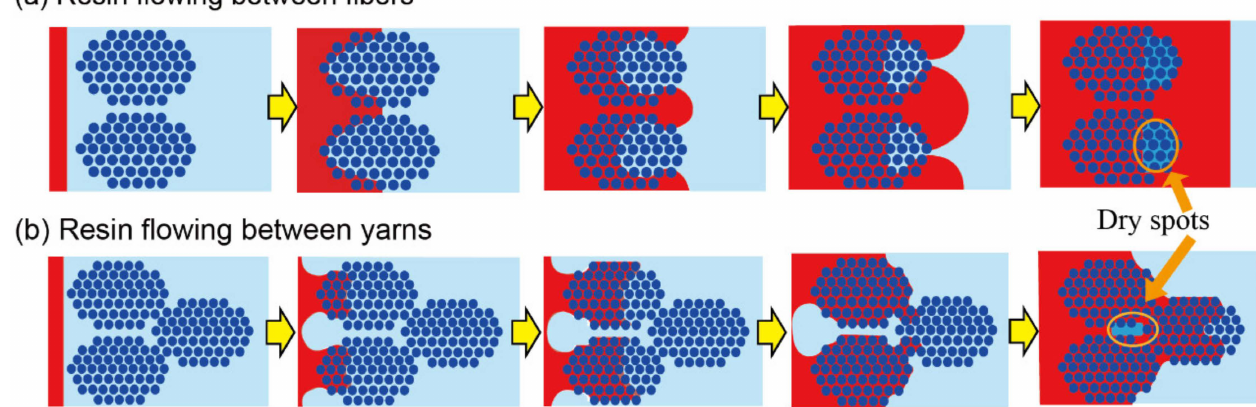
Figure 7. Dry spots forming during the resin flowing process in RTM. ( a ) Dry spots between fibers and ( b ) Dry spot between